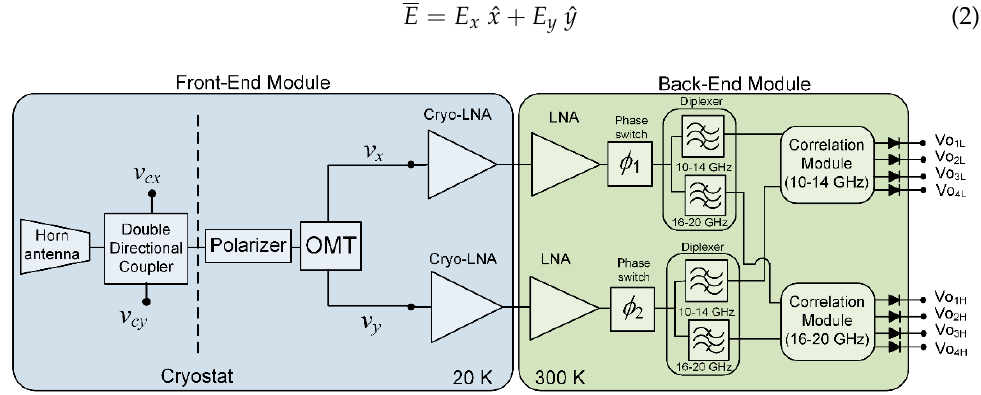
Figure 1. Block diagram of the full receiver, with the front-end module (FEM) operating at cryogenic temperature (in blue) and the back-end module (BEM) at ambient temperature (in temperature (in blue) and the back-end module (BEM) at ambient temperature (in green).